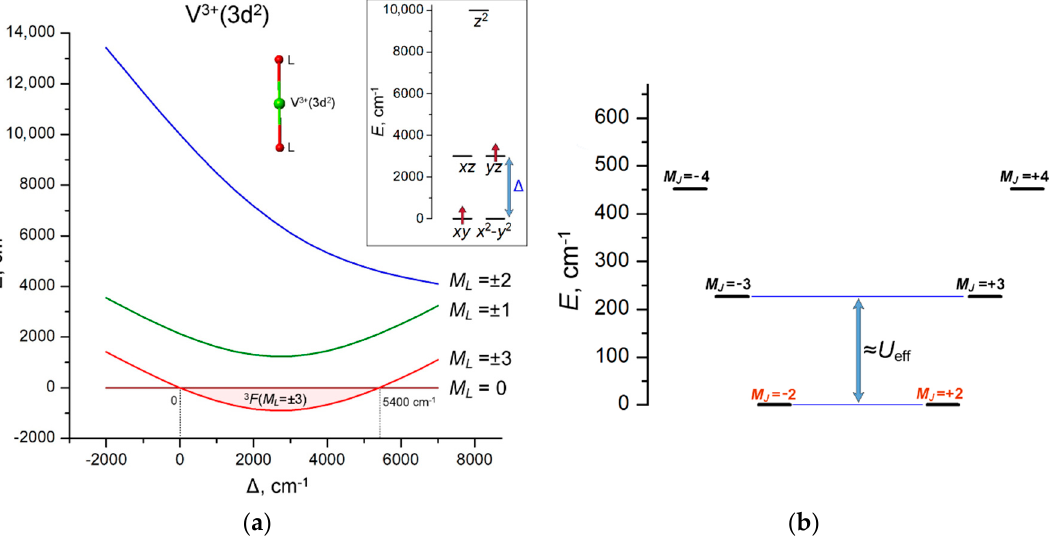
Figure 2. ( a ) Variation of the energies of the 3 F ( M L ) LF states of V 3+ (3d 2 ) ion in linear coordination with increasing energy separation Δ = E ( xz , yz ) − E ( xy , x 2 − y 2) between the lowest and first excited sets of 3d orbitals. The range of the stabilization of the 3 F ( M L = ±3) ground state (0 ≤ Δ ≤ 5400 cm − 1 ) is marked with light pink. Inset: the LF splitting pattern of 3d orbitals in a linear two-coordination, E ( xy , x 2 − y 2) = 0, E ( z 2 ) = 10,000 cm − 1 (fixed) and E ( xz , yz ) = Δ (variable); ( b ) E vs. M J diagram calculated at Δ = 3000 cm − 1 . The spin-reversal barrier U eff ≈ 200 cm − 1 is approximately estimated by the energy separation between the ground M J = ±2 and the first excited M J = ±3 states.